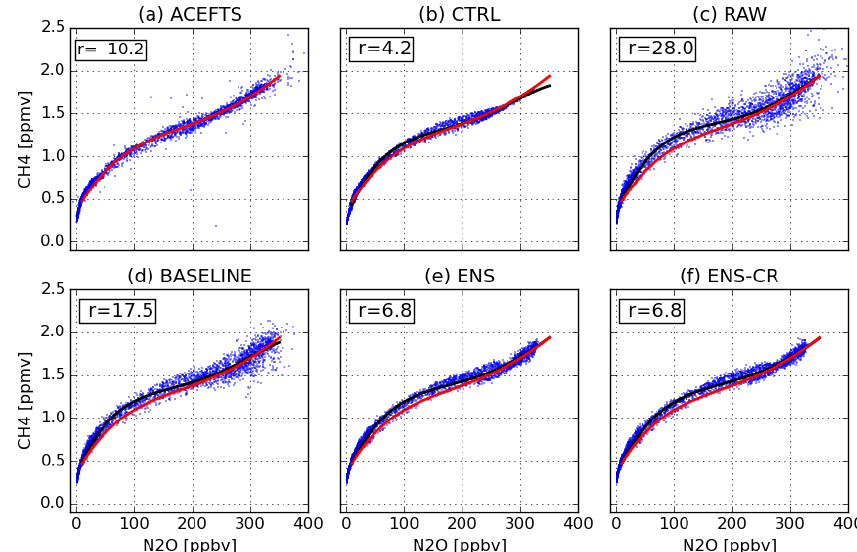
Figure 5. N 2 O–CH 4 scatter plots between 30 ◦ S–30 ◦ N as observed by ACE–FTS (a) and for five BASCOE experiments interpolated to the ACE–FTS observation space (b–f) . The correlations are shown for the period April–October 2008. The result of a four-degree polynomial fit is also shown (red line for ACE–FTS, black lines for BASCOE experiments) with the root mean square of the residual between the fitted curve and the observations printed in the upper left of each plot. The correlation curve of ACE–FTS (red curve) is reported in the correlation plots of the BASCOE experiments (b–f) .